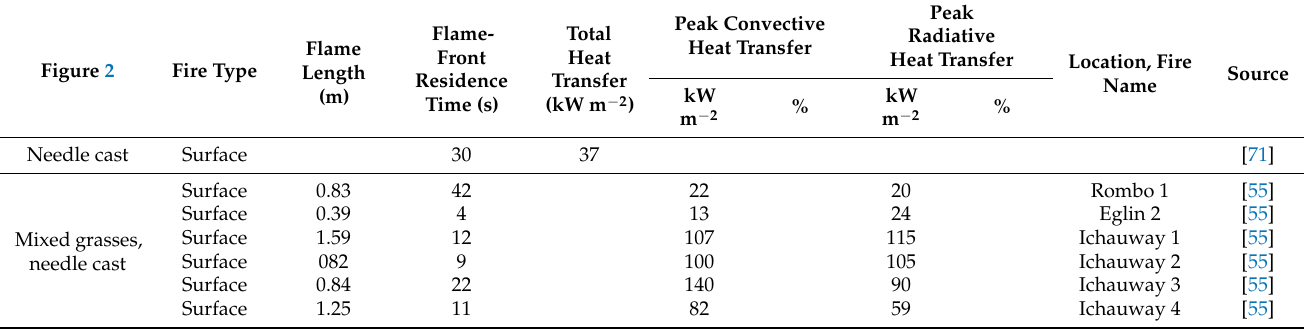
Table 2. Convective and radiative heat transfer in wildland fires for different fuel and fire types. It is important to note that convective heat flux is usually inferred from measurements of a total heat flux gauge, the geometry of which is not representative of wildland fuels, so these values must be considered with